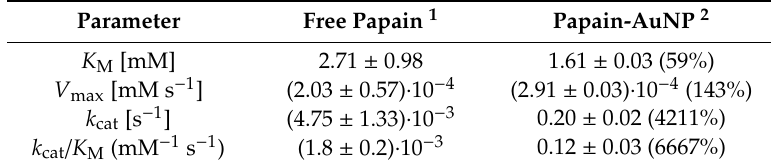
Values represent mean ± standard deviation of three replicate experiments. Adapted with permission from ref. [112]. Copyright 2017 Elsevier B.V., Amsterdam, Netherlands 1 The final papain concentration in the digestion